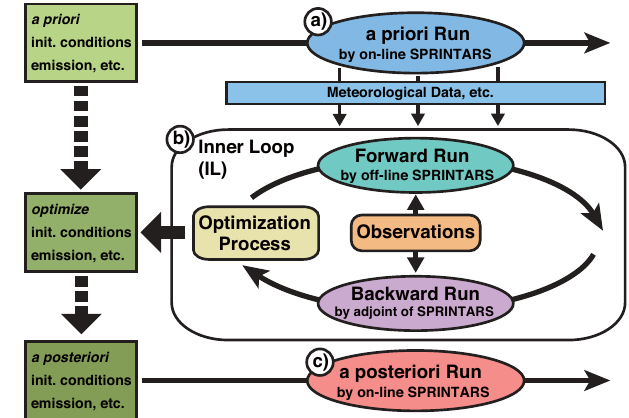
Fig. 1. Schematic diagram of the SPRINTARS/4D-Var data assim- ilation system. (a) a priori run, (b) inner loop, and (c) a posteriori